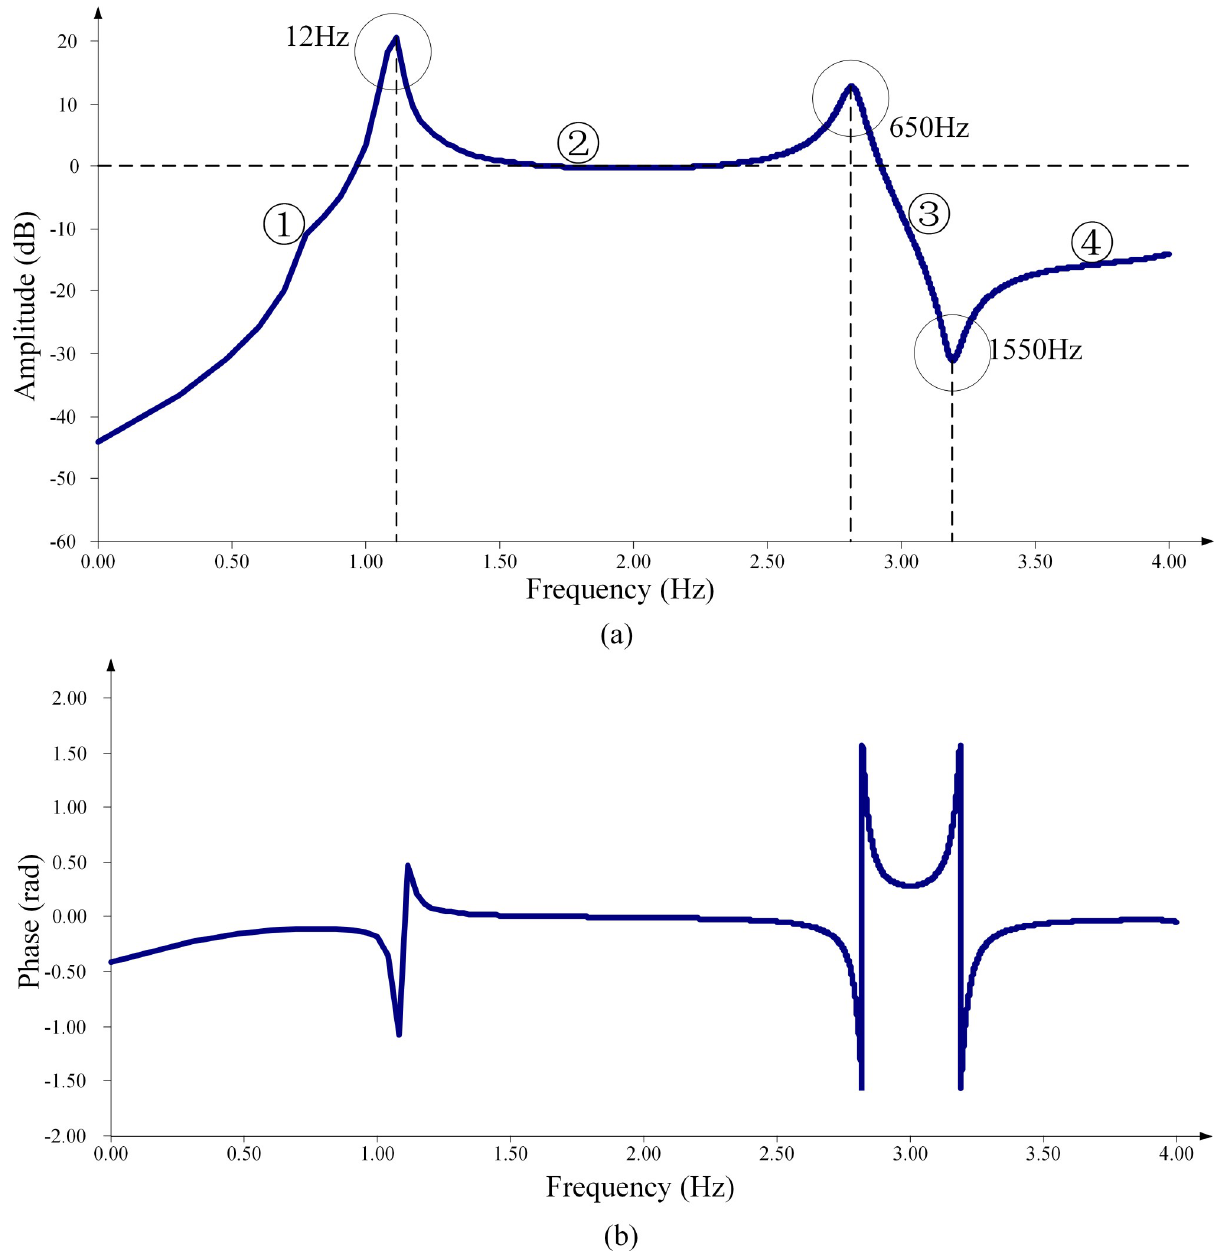
Fig 6. Frequency response characteristics of the ratio of the CVT with a speedy saturation damper. (a) Amplitude-frequency characteristic. (b) Phase-frequency characteristic.